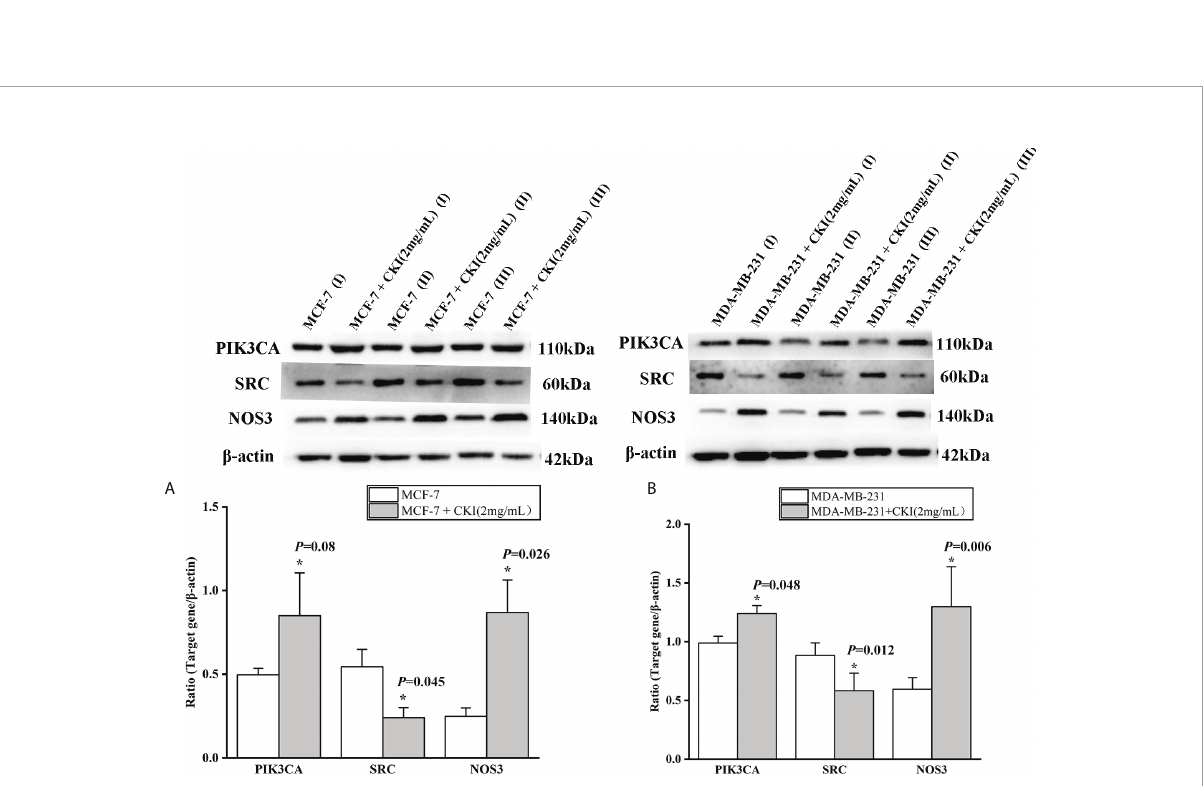
FIGURE 11 The protein expression of PIK3CA, SRC and NOS3 in MCF-7 cells and MDA-MB-231 cells. Notes: (A) The expression levels of PIK3CA, SRC and NOS3 protein in MCF-7 cells; (B) The expression levels of PIK3CA, SRC and NOS3 protein in MDA-MB-231 cells. Lane-I, III, V represented MCF-7 (MDA-MB-231) cells group; Lane-II, IV, V represented MCF-7 (MDA-MB-231) cells with 2 mg/ml CKI treatment group. n=3. Data are presented as means ± SD. * P < 0.05, compared with MCF-7(MDA-MB-231)